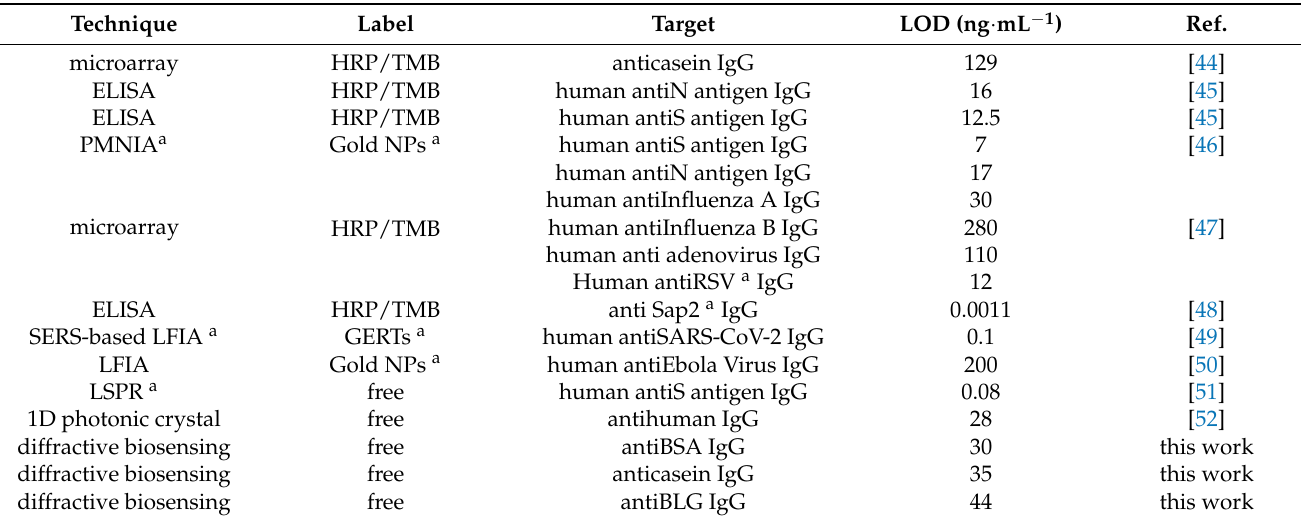
Table 2. Comparative table of limits of detection reported by recent optical bioanalytical develop- ments in the scientific literature for sensing specific IgGs.